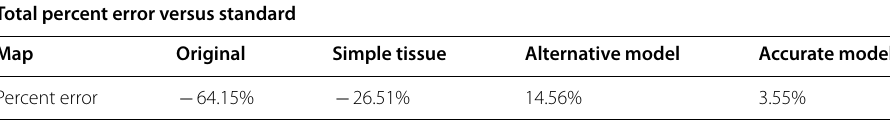
Table 3 Percent errors of the total cadaver activity compared to the gold standard Total percent error versus